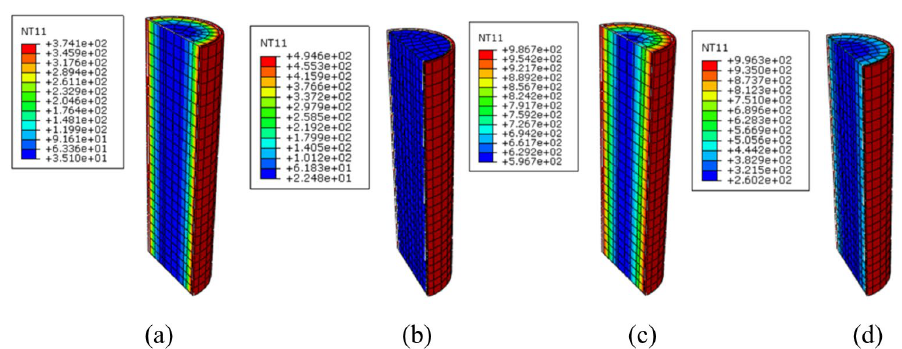
Figure 8. Models for assessing the air-gap effect: (a) perfect thermal contact (15 min.), (b) with air-gap layer of 2-mm thickness (15 min.), (c) perfect thermal contact (90 min.) and (d) with air-gap layer of 2-mm thickness (90 min.)